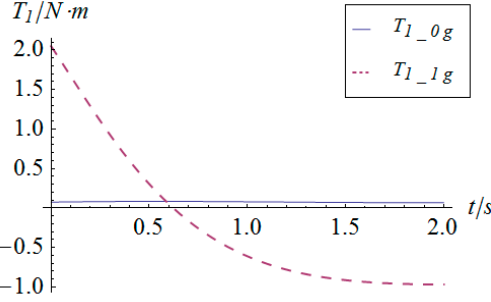
Figure 10. Driving torque vs. time of actuator 1.